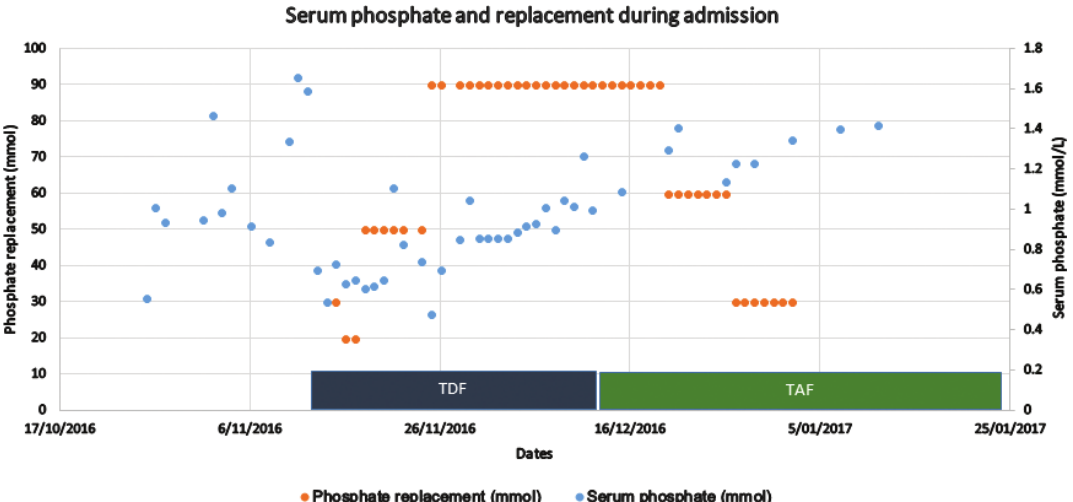
Figure 2. Serum phosphate levels rise and oral phosphate replacement requirements fall significantly and acutely on change from TDF to